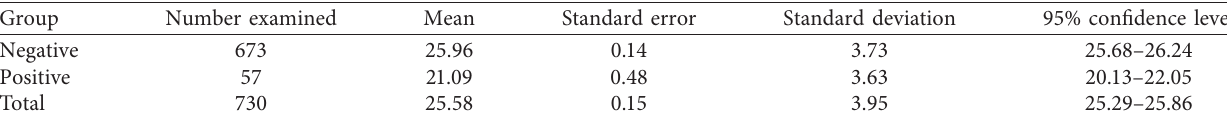
Table 2: The mean PCV of positive and negative cattle for trypanosomosis examined in West Gojjam, Northwest Ethiopia. Group